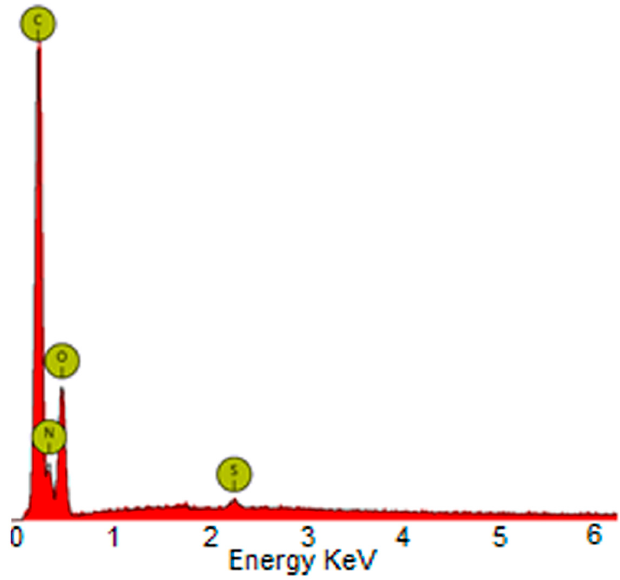
Figure 4. EDS of imprinted membrane Pd-IAzoCsM.